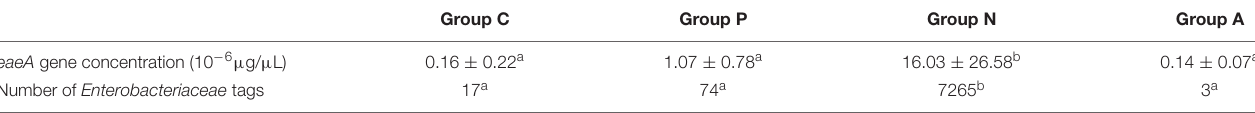
TABLE 3 | eaeA gene levels and sums of Enterobacteriaceae tags in rabbit cecal contents (Mean ± SD or Sum).